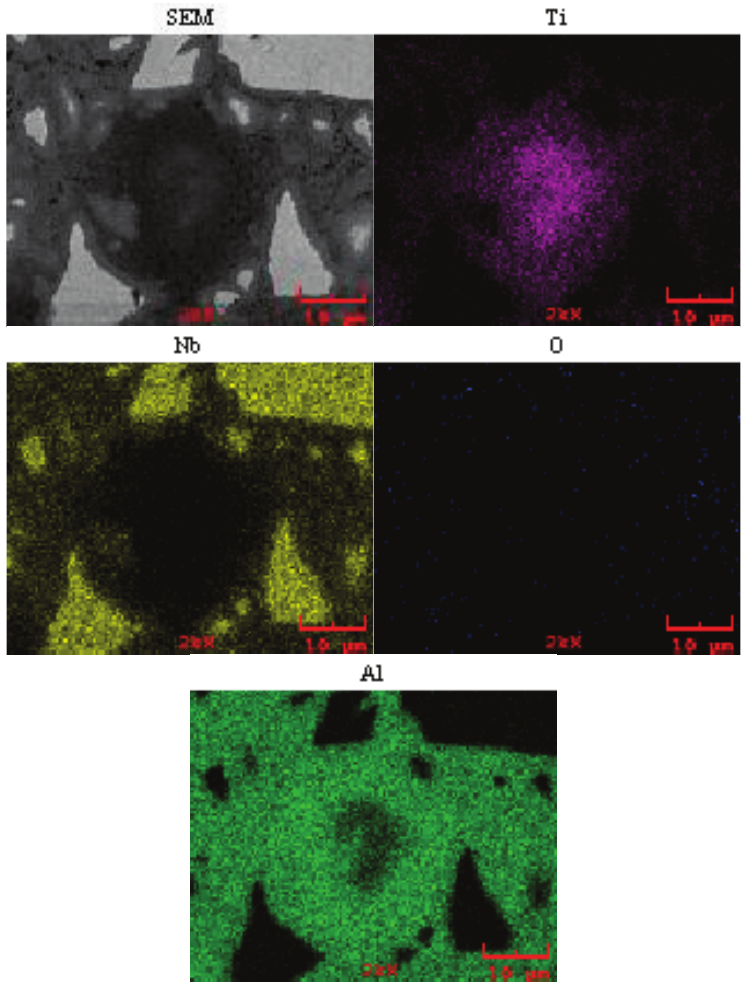
Figure 7: SEM-Map Analyses of C3 sample.